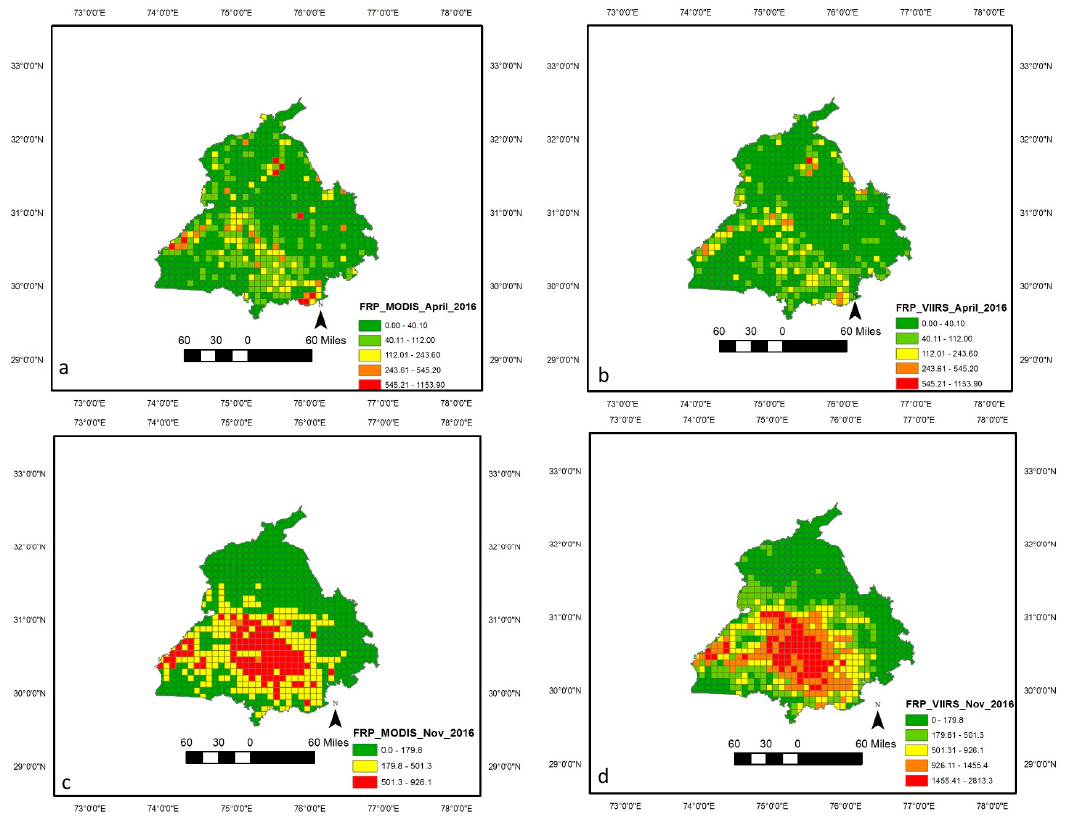
Figure 4. Sum of fire radiative power (FRP) from MODIS and VIIRS for the peak months of summer (April) ( a , b ) and winter (November) ( c , d ), 2016. FRP data has been gridded at 5 arc minute grid intervals (10 km cells). High FRP during November captured by VIIRS data can be seen in Figure 4d.